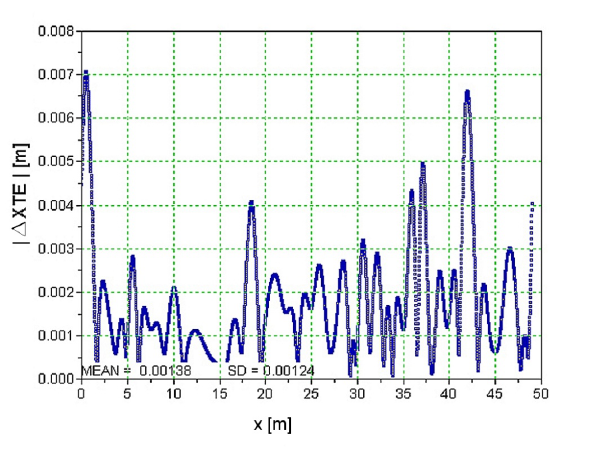
Figure 10: The absolute values of ∆XTE for assessed straight track section.